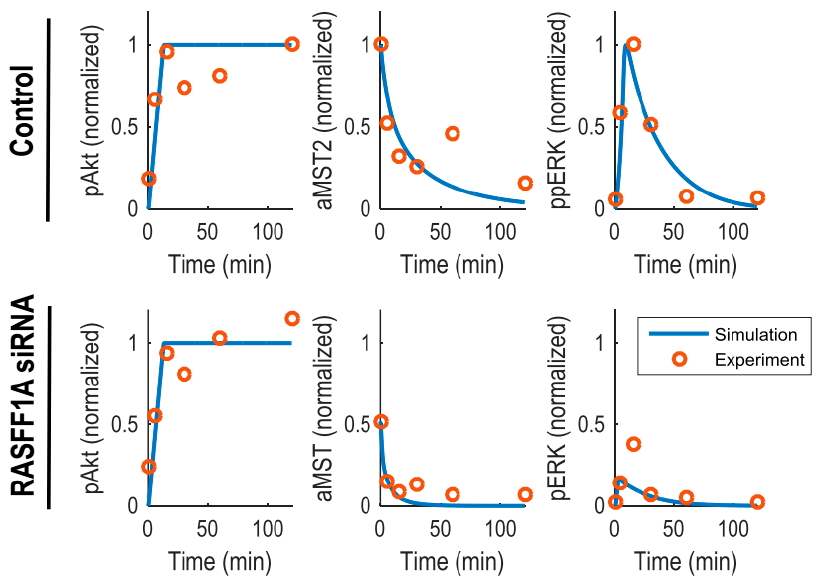
Figure 2. Model training and kinetic parameter estimation for the integrated Hippo-ERK signalling network. The time-course data were obtained in HeLa cells [6]. The levels of phosphorylated (active) Akt (pAkt), ERK (ppERK) and MST2 (aMST2) were measured at 6 time points over 2 h serum stimulation under untreated and RASSF1A knockdown conditions. The experimental and simulation data are represented by the red circle and blue line, respectively. RASFF1A siRNA denotes RASSF1A knockdown